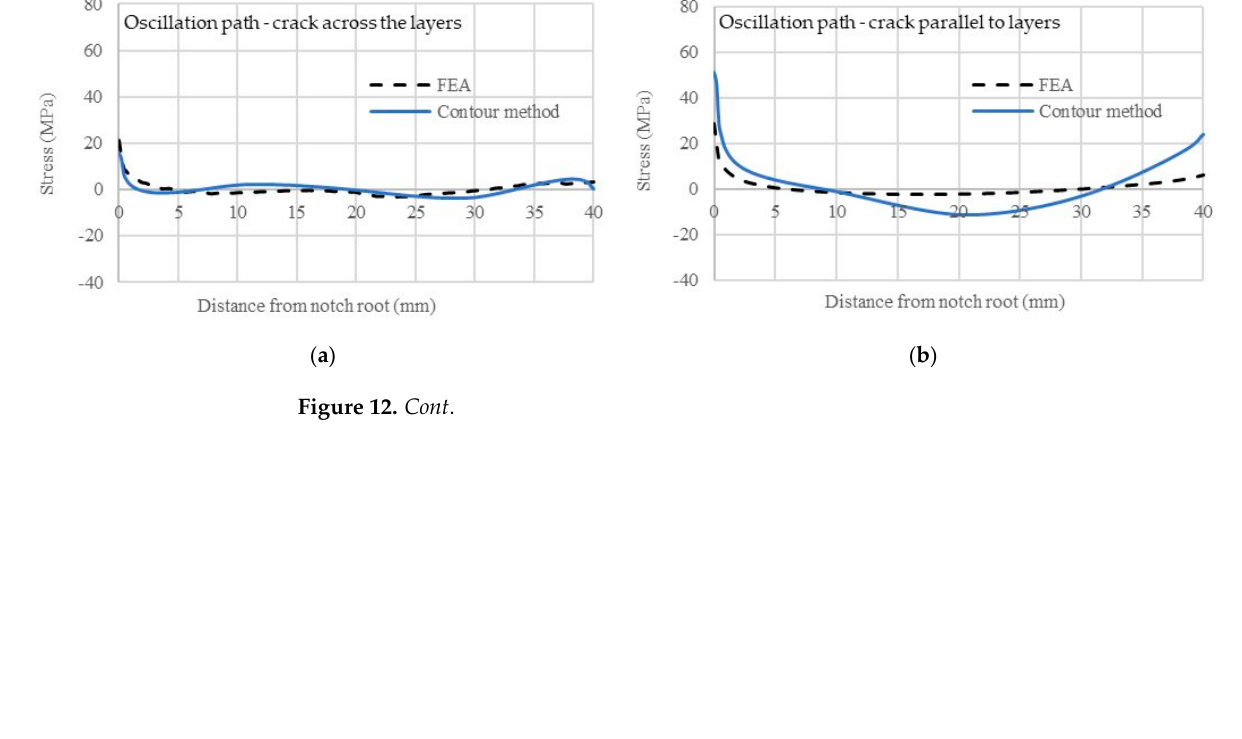
Figure 11. FE stress maps of CT coupons with cracks parallel to the build layers: ( a ) oscillation path (62.5 mm × 62 mm), ( b ) parallel path (80 mm × 76 mm), ( c ) single bead (80 mm × 76 mm), ( d ) sketch of the crack orientation (unit: MPa).